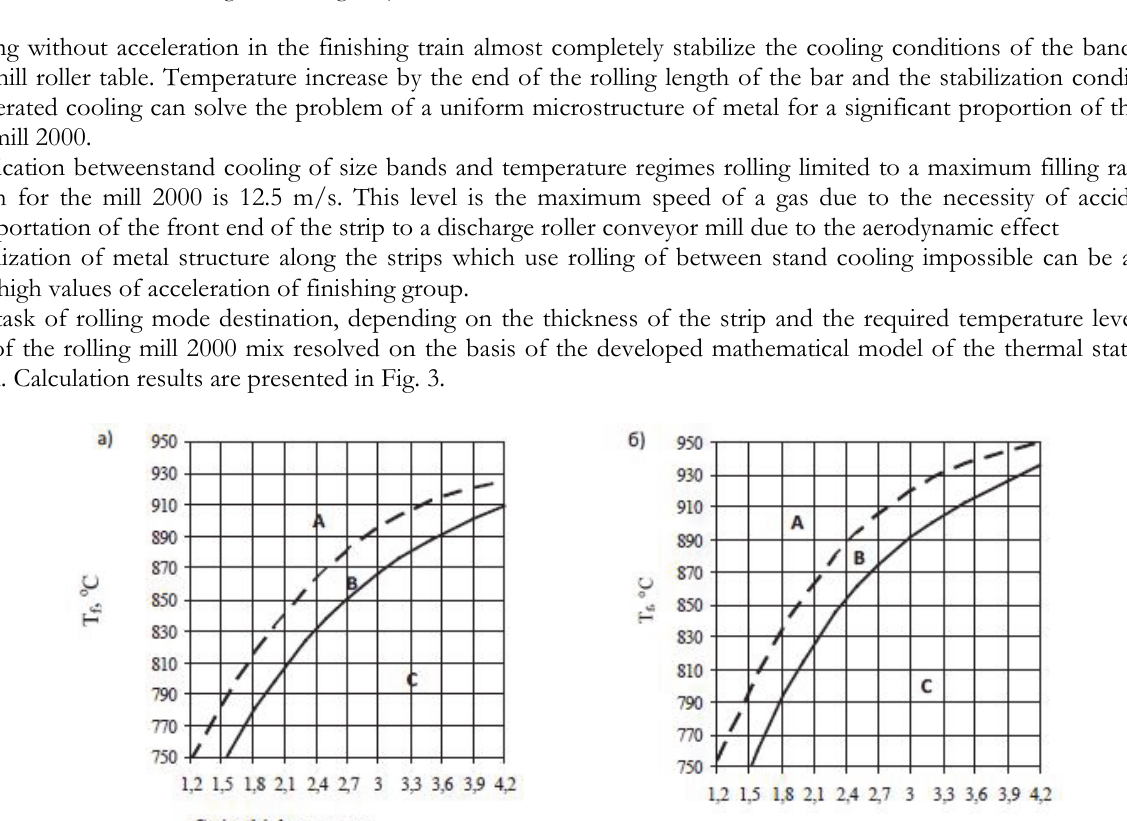
Figure 2: Calculated parameters of hot rolling and accelerated cooling. Strip 3x1250 mm of steel 08U (tr = 1000 °C , Vth = 9 m/s, a = 0,026 m/s, tf = constant (840 °C ), cooling temperature (tc) + 640 °C , QMKO = 0; tr = 1000 °C , Vth = 11,2 m/s, a = 0, tf = constant, QMKO = constant, tc = 640 °C ; in Fig. 2A, - water slow in Fig. 2B, m 3 /h; Fig. 2C – average grain size after finishing group, mcm, in Fig. 2C and number of cooling units in Fig. 2D).